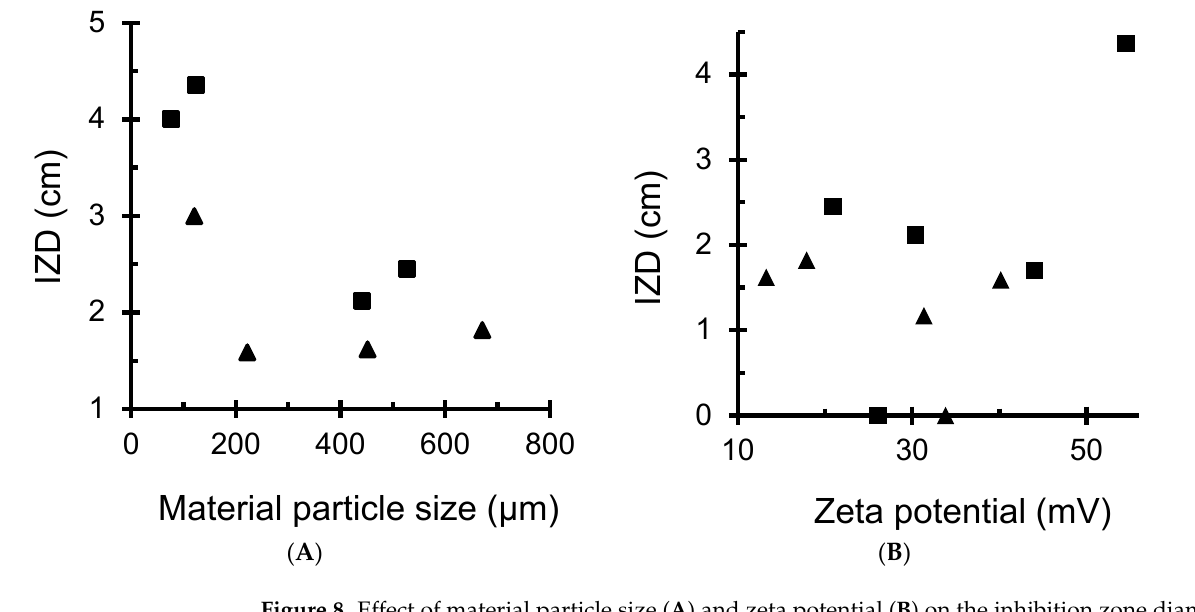
Figure 8. Effect of material particle size ( A ) and zeta potential ( B ) on the inhibition zone diameter (IZD). In black square: CMC-based samples, including Cu 2+/ CMC, Cu 0 /CMC, Ag + /CMC and Ag 0 /CMC. In black triangle: CMS-based samples, including Cu 2+/ CMS, Cu 0 /CMS, Ag + /CMS and Ag 0 /CMS.